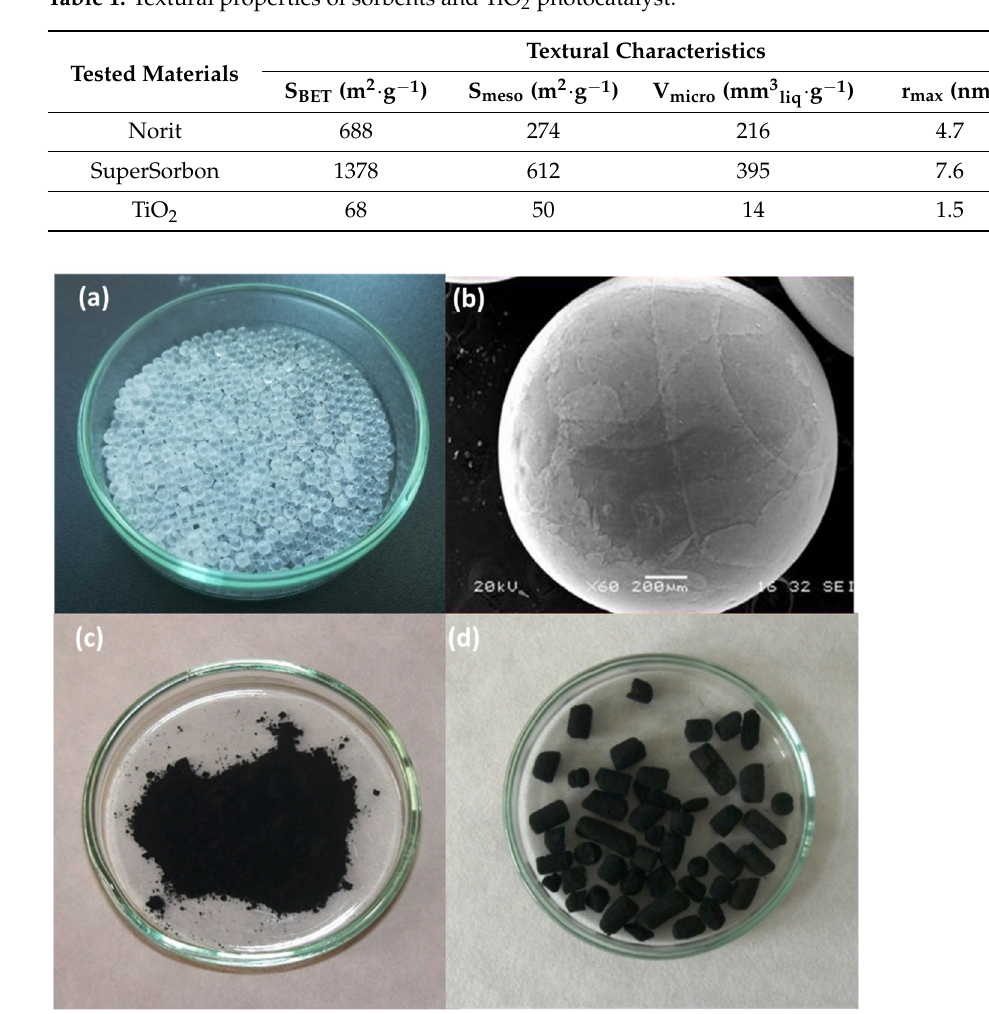
Figure 3. Used photocatalysts and sorbents. ( a ) Glass beads with TiO 2 layer. ( b ) Glass beads with TiO 2 . ( c ) Activated charcoal Norit. ( d ) Activated charcoal SuperSorbon. TiO 2 . ( c ) Activated charcoal Norit. ( d ) Activated charcoal Table 1. Textural properties of sorbents and TiO 2 photocatalyst.